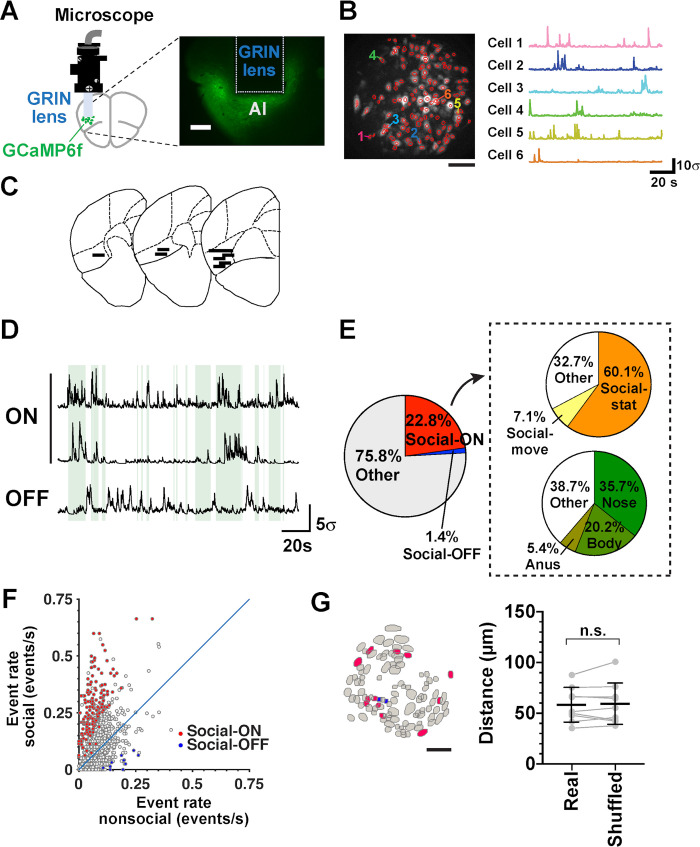
Social-ON cells and Social-OFF cells in the AI.(A) A schematic of microendoscopic imaging (left). AI neurons virally transfected with GCaMP6f were imaged using a miniaturized head-mounted microscope through a chronically implanted GRIN lens. A fluorescence image of a coronal section shows the trace of a GRIN lens implanted close to GCaMP6f-expressing AI neurons (right). Scale bar = 200 μm. (B) A FOV showing contours of a population of imaged AI neurons (left, scale bar = 100 μm). Six example neurons are numbered, and their time-varying GCaMP6f fluorescence changes are shown on the right side. (C) Reconstructed positions of the implanted GRIN lenses in the AI (n = 9 mice). Approximate centers of the lenses along the anteroposterior axis are shown by black horizontal lines in drawings of representative coronal sections modified from the Allen Mouse Brain Atlas. (D) GCaMP ΔF/F traces of 2 Social-ON cells and a Social-OFF cell. The epochs of social interaction are indicated in green. (E) A pie chart showing the fractions of each category of cells in the total cell population (left, n = 737 cells from 9 mice). “Other” in the left chart includes cells whose activity was either correlated with passive touch by the stranger (0.9% of total cells), overall moving periods (2.3% of total cells), or overall stationary periods (2.4% of total cells). The pie charts shown within the dashed rectangle demonstrate the fractions of each subcategory of cells in the Social-ON cell population (n = 168 cells). (F) A scatter plot of Ca2+ event rates of individual neurons during social interaction and nonsocial periods (n = 737 cells from 9 mice). The blue line indicates equivalence. Social-ON cells (n = 168 cells) and Social-OFF cells (n = 10 cells) are shown in red and blue, respectively (S1 Data, sheet Fig 2F). (G) Anatomical distribution of social cells in a FOV (left, n = 106 cells). Social-ON cells (n = 12 cells) and Social-OFF cells (n = 2 cells) are shown in red and blue, respectively. Scale bar = 100 μm. Average NNDs between Social-ON cells calculated using real (“Real”) and shuffled data (“Shuffled”) are shown in the right panel (P = 0.59, real versus shuffled, t(8) = 0.55, paired t test, n = 9 mice; S1 Data, sheet Fig 2G). AI, agranular insular cortex; FOV, field of view; GCaMP6f, GFP-based Calcium Calmodulin Probe 6f; GRIN, gradient refractive index; NND, nearest neighbor distance.